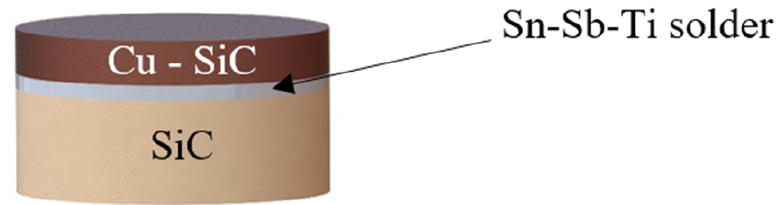
Figure 3. Assembly of a soldered joint for analysis of solder/substrate boundaries. The joints were fabricated using a hot plate with thermostatic regulation. The SiC